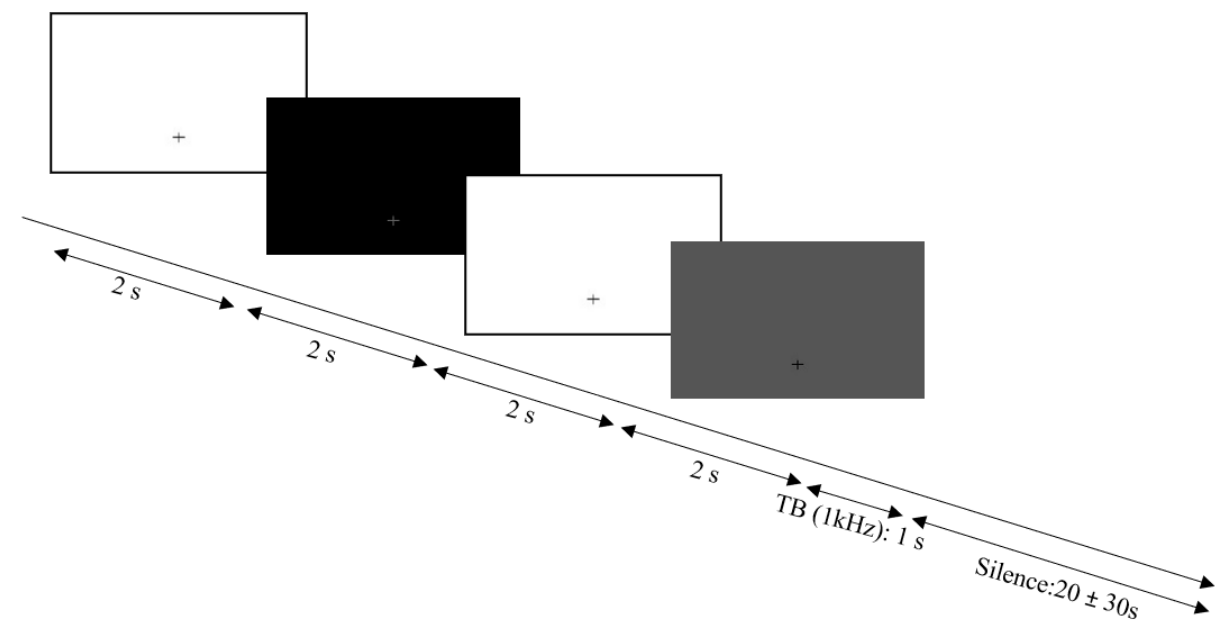
Figure 1. Pupillometry paradigm. Progression of the visual stimuli: first a white image was presented for 2 s, followed by a black image for 2 s, followed by a white image for 2 s, followed finally by a gray image, which remained present during the experimental run. A 1-kHz tone burst was presented at an interval of 20–30 s.